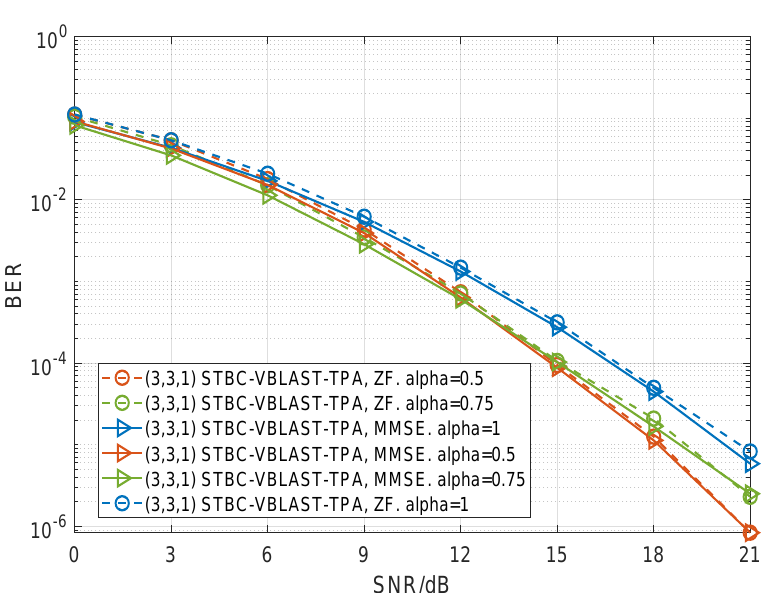
Figure 5. Performance comparisons of the (4, 4, 1) STBC-VBLAST-SM systems having θ = π θ = 0.